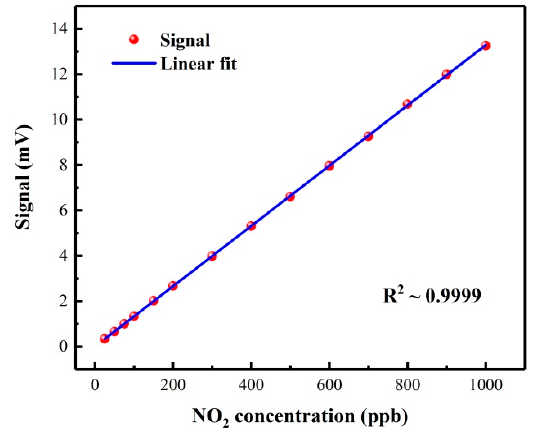
Figure 7 . Response linearity of the NO 2 photoacoustic sensor at different NO 2 concentrations.